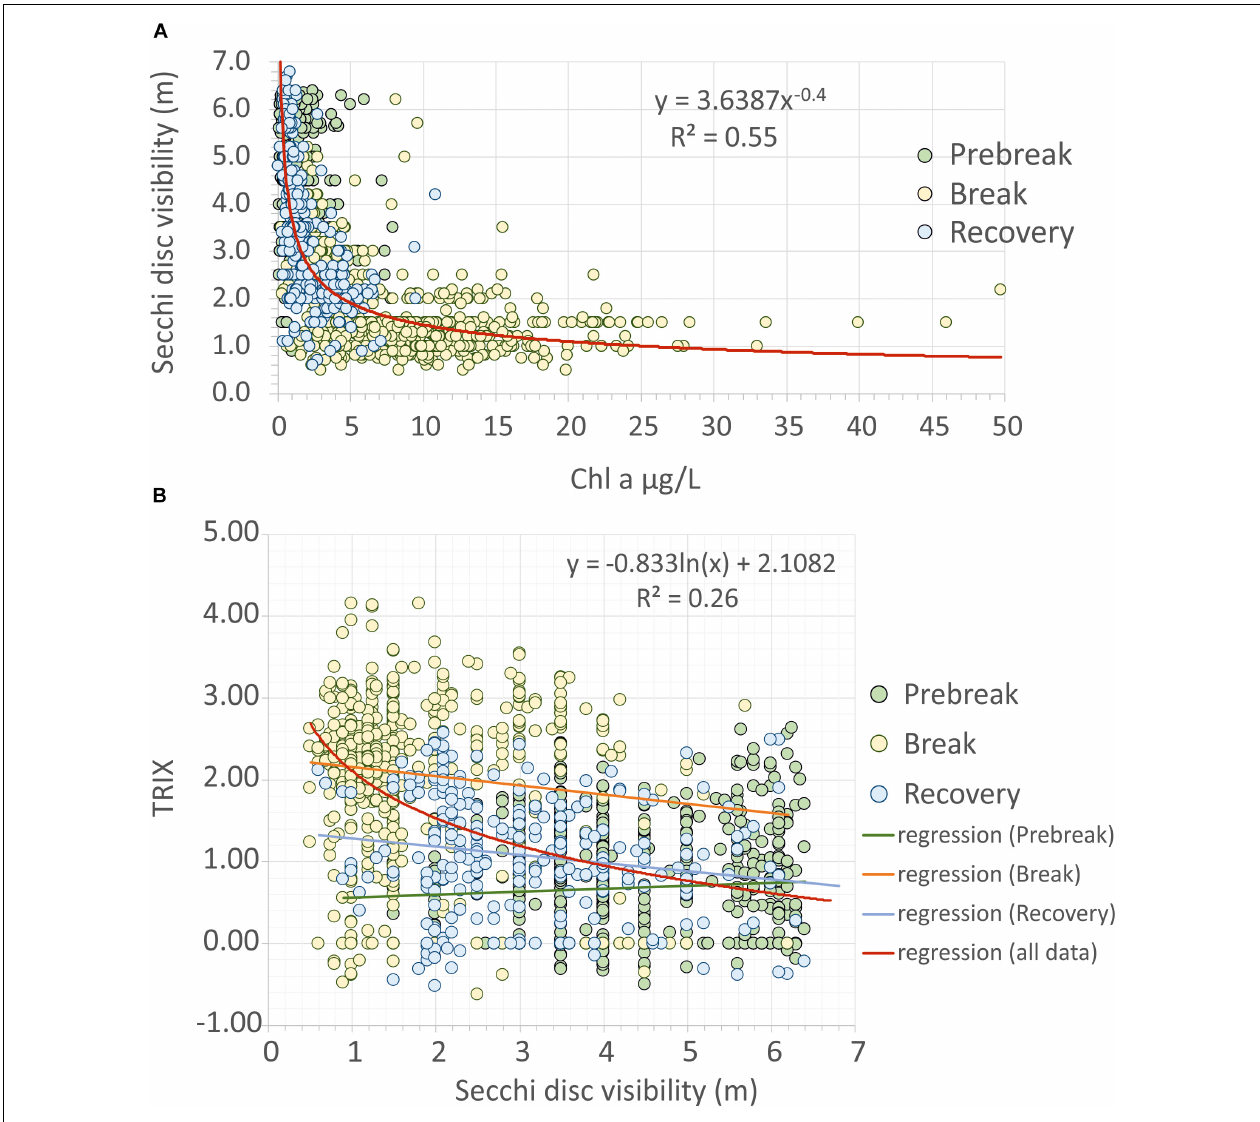
FIGURE 9 | (A) Relationship between water column transparency measured by Secchi disc visibility depth and chlorophyll a concentration at each locality during the studied period (1997–2018); (B) relationship between TRIX trophic index and water column transparency using the same samples than in B . The color of the points represents the phase of the trophic state to which they belong. The red line corresponds to the regression model that best fits all the data. In figure B , the colored lines correspond to the linear regression considering the points belonging, respectively, to each of the phases of the trophic state.